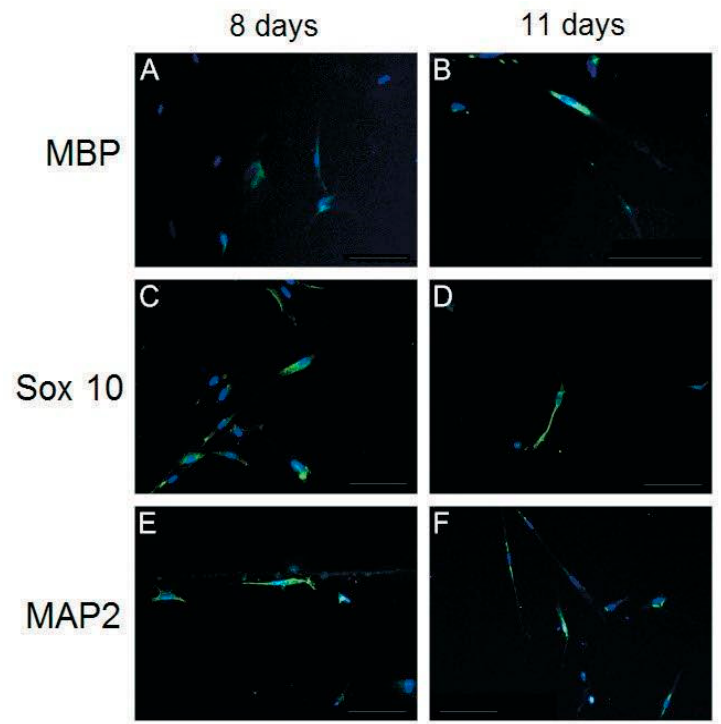
Figure 4. Characterization of differentiated placenta-derived multipotent stem cells (PDMCs) after culturing with the induction medium from Schwann cell-like cells for 8 and 11 days. Expression of MBP (myelin basic protein) and Sox 10 was observed on days 8 and 11 ( A – D ) but not on days 5 or 14 (data not shown). The highest expression of MBP was observed on day 11 ( B ). By contrast, the highest expression of Sox 10 was observed on day 8 (C). Immunofluorescence staining of MAP2 (Microtubule-associated protein 2) was slightly higher on day 8 ( E ) than on day 11 ( F ). Nuclei are labeled with DAPI ( 4 ′ ,6-diamidino-2-phenylindole) (blue). Bar, 100 μ m.